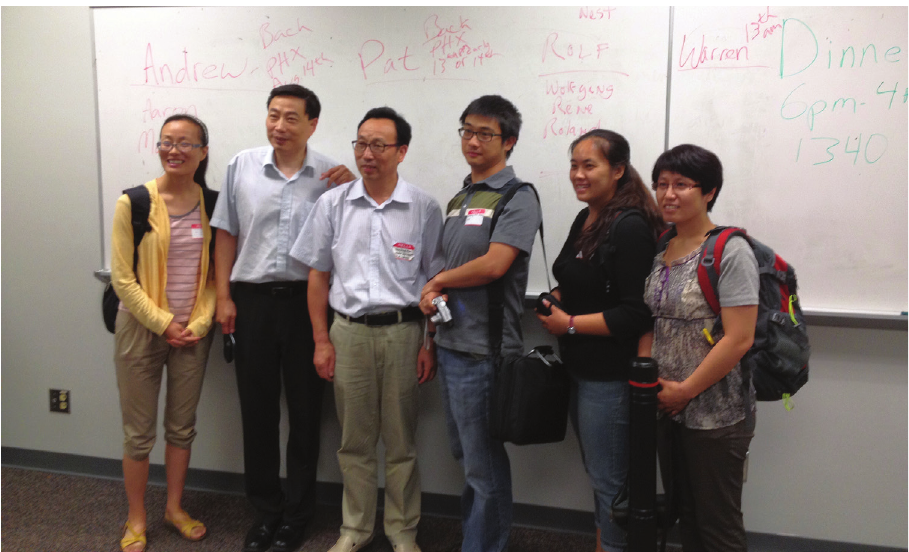
Figure 3. Visiting Chinese and US-based Chinese researchers. Left to right: Yuxia Yang, Li Zhong, Guodong Ren, Guanyang Zhang (ASU postdoc), Shanshan Liu, Caixia Yuan